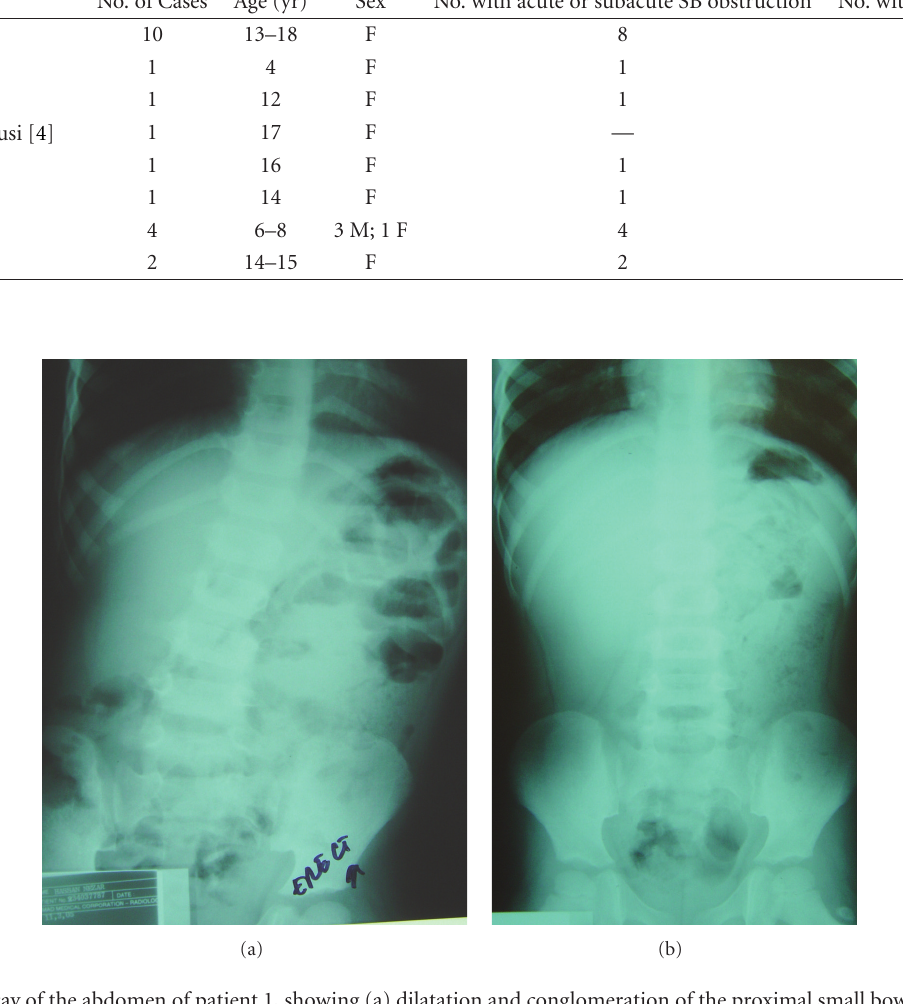
Figure 1: Plain X-ray of the abdomen of patient 1, showing (a) dilatation and conglomeration of the proximal small bowel in the left upper quadrant of the abdomen, (b) the fixed clusters of small bowel maintained a constant position.